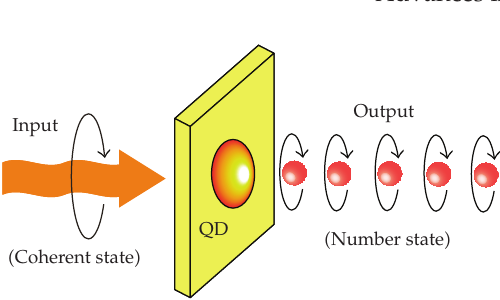
Figure 5: Schematic of polarization-preserved photon state converter based on a single quantum dot. Incident laser light is in the coherent state with the Poissonian photon number distribution. This photon statistics is converted ideally into the number state with deterministic and controllable output photon number per single excitation event.